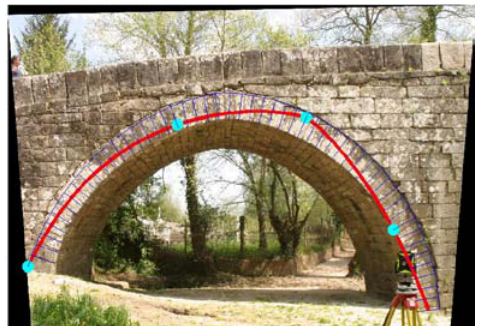
Figure 7. Graphic results of the structural analysis. Representation of the thrust line as well as the four-hinges